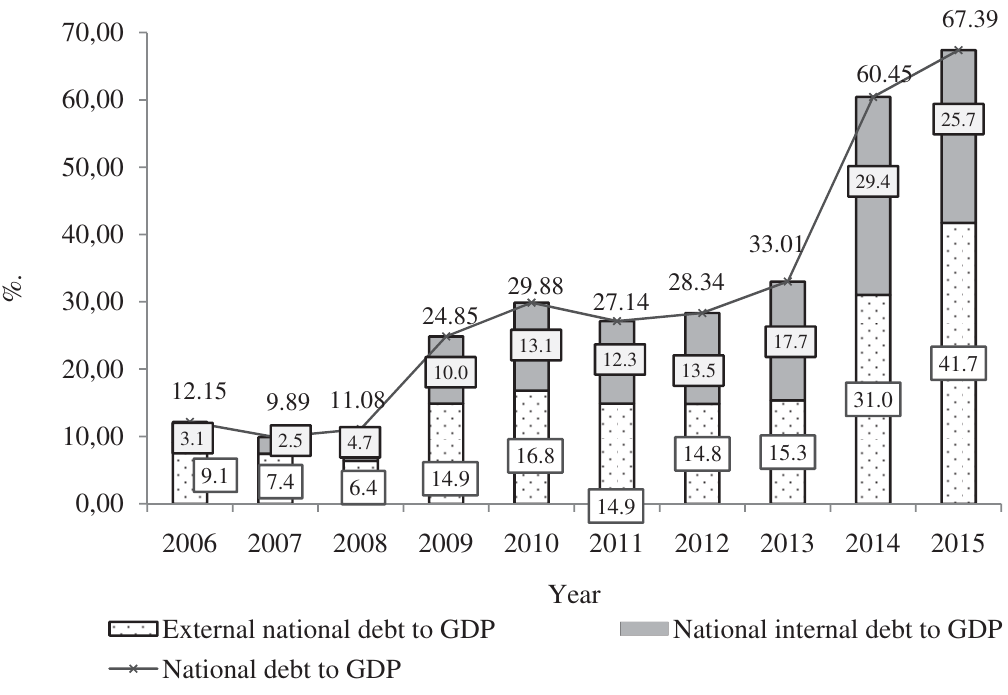
Fig. 8. The dynamics of change of national debt volume to GDP ratio in 2006-2015,